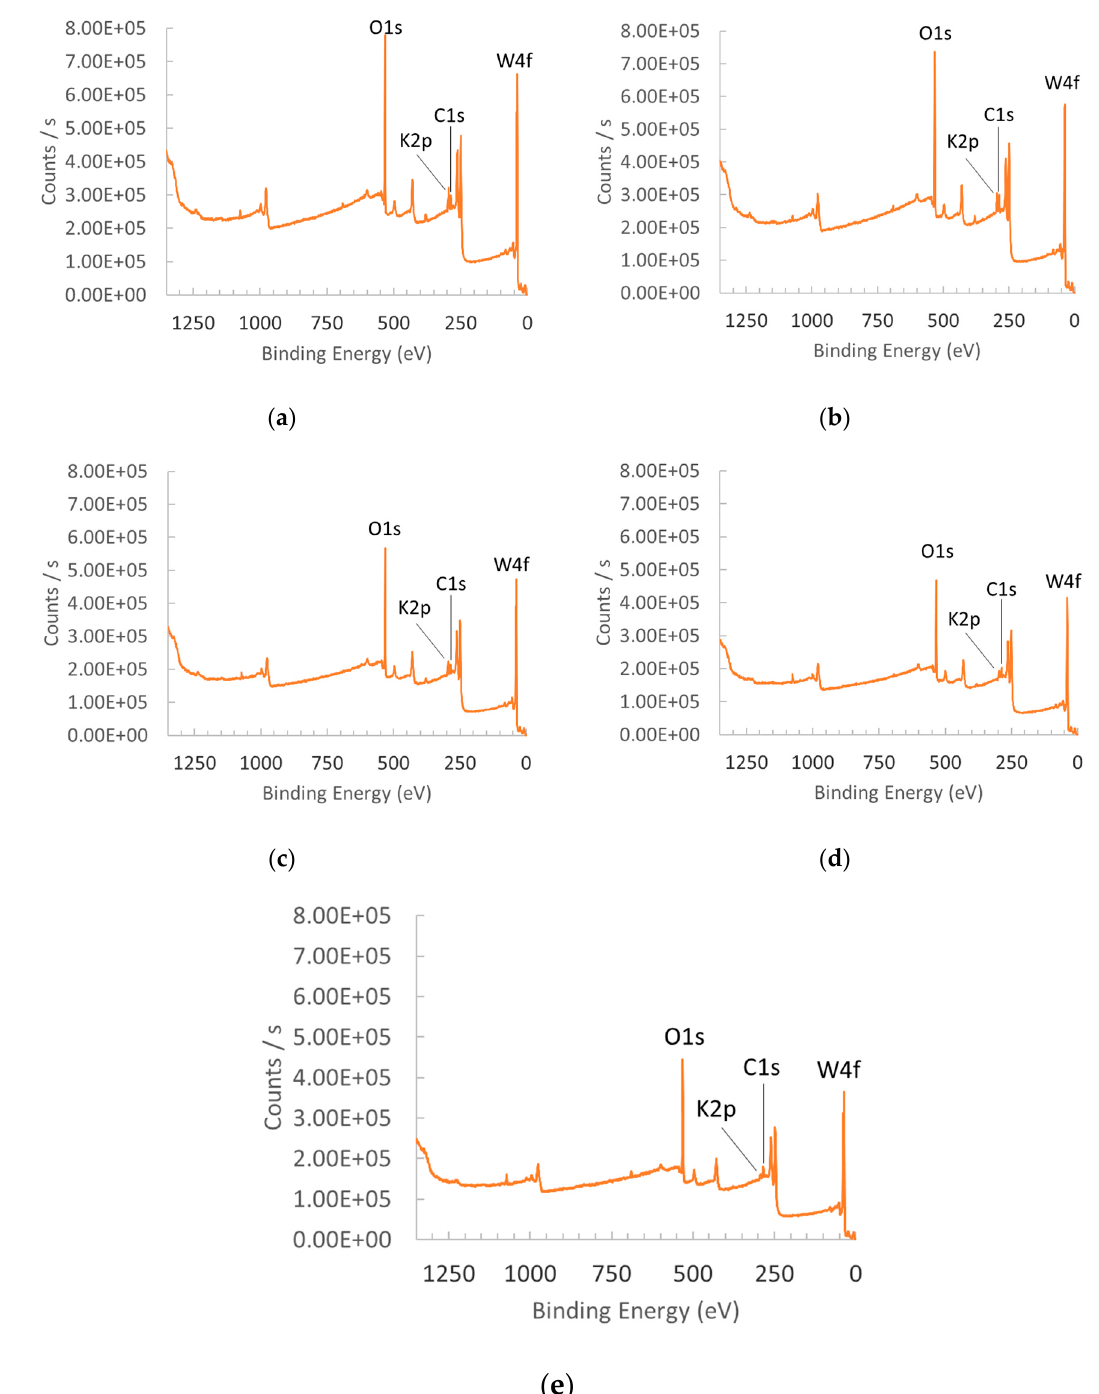
Figure A1. XPS of K x W 7 O 22 with x = ( a ) 2.2, ( b ) 2.0, ( c ) 1.8, ( d ) 1.5, and ( e ) 1.2.